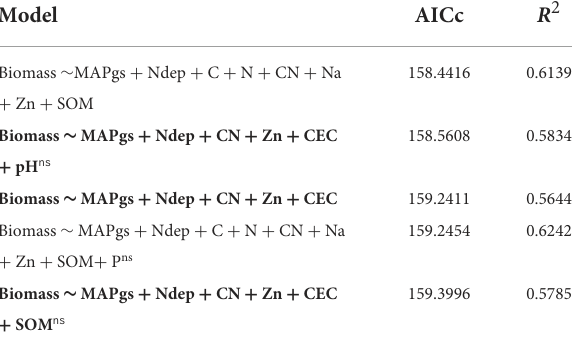
TABLE 1 The best models explained the variation in biomass. Model